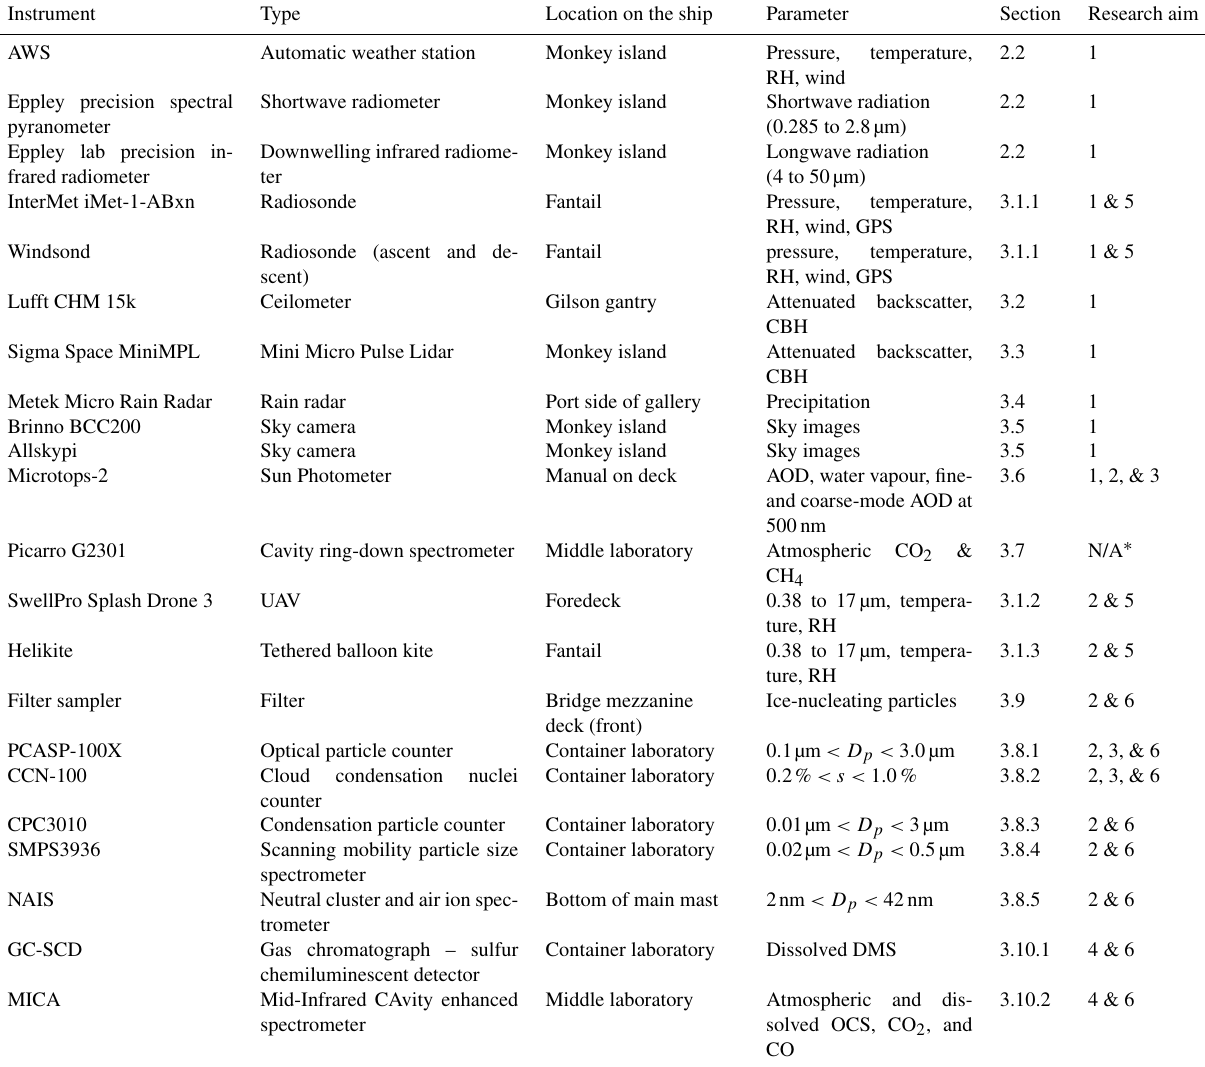
Table 2. Table of instruments related to aerosol–cloud interactions that were deployed on the RV Tangaroa and are described in this study.